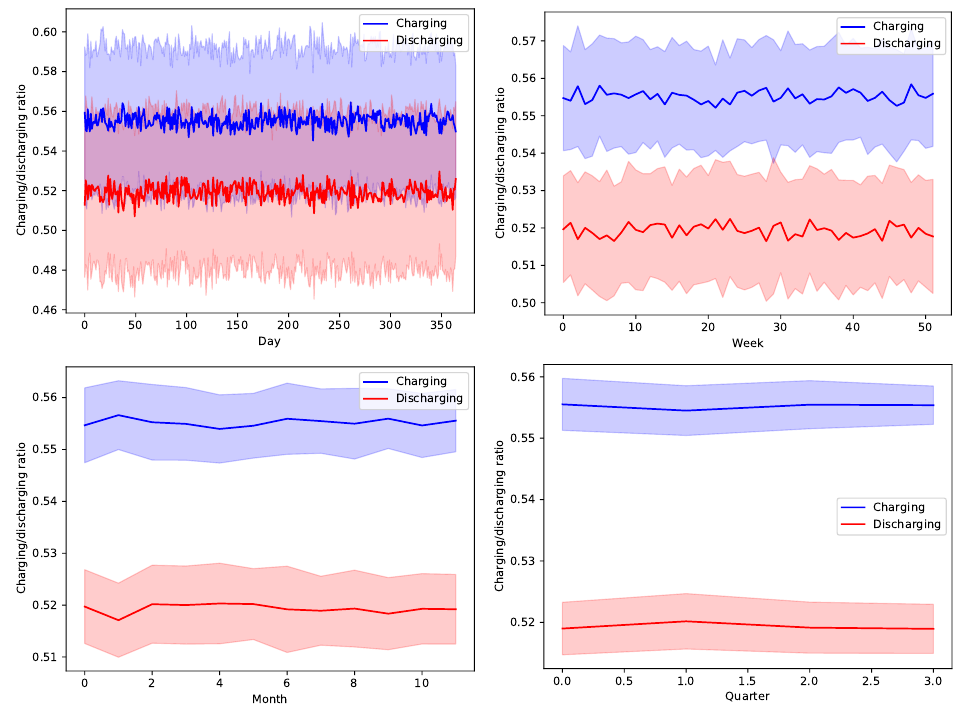
Figure 17. The average temporal charging and discharging ratios of EVs according to the greedy policy with a global certainty level U 95 .